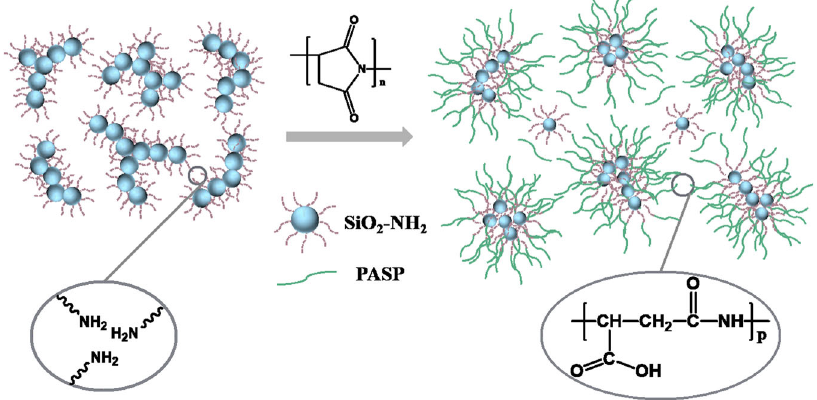
Fig. 1 Synthesis route of SiO 2 -NH 2 /PASP scale inhibitor. SiO 2 -NH 2 nanosilica containing reactive amino group, PASP polyaspartic acid.